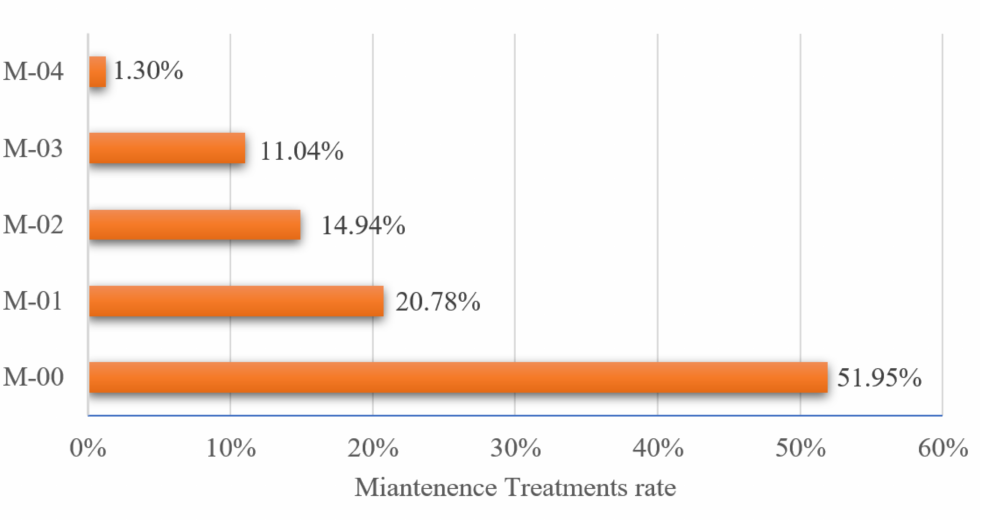
Figure 9. Optimal distribution of maintenance activities.